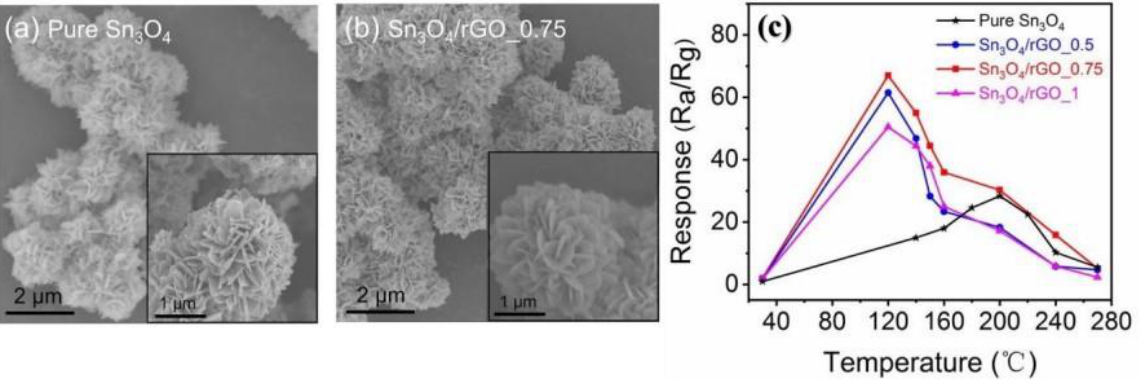
Figure 12. FESEM images of ( a ) pure Sn 3 O 4 ; ( b ) Sn 3 O 4 /RGO-0.75 composite; ( c ) Sensing response of with varying content of rGO sensor toward 100 ppm HCHO at different operating temperatures [81].